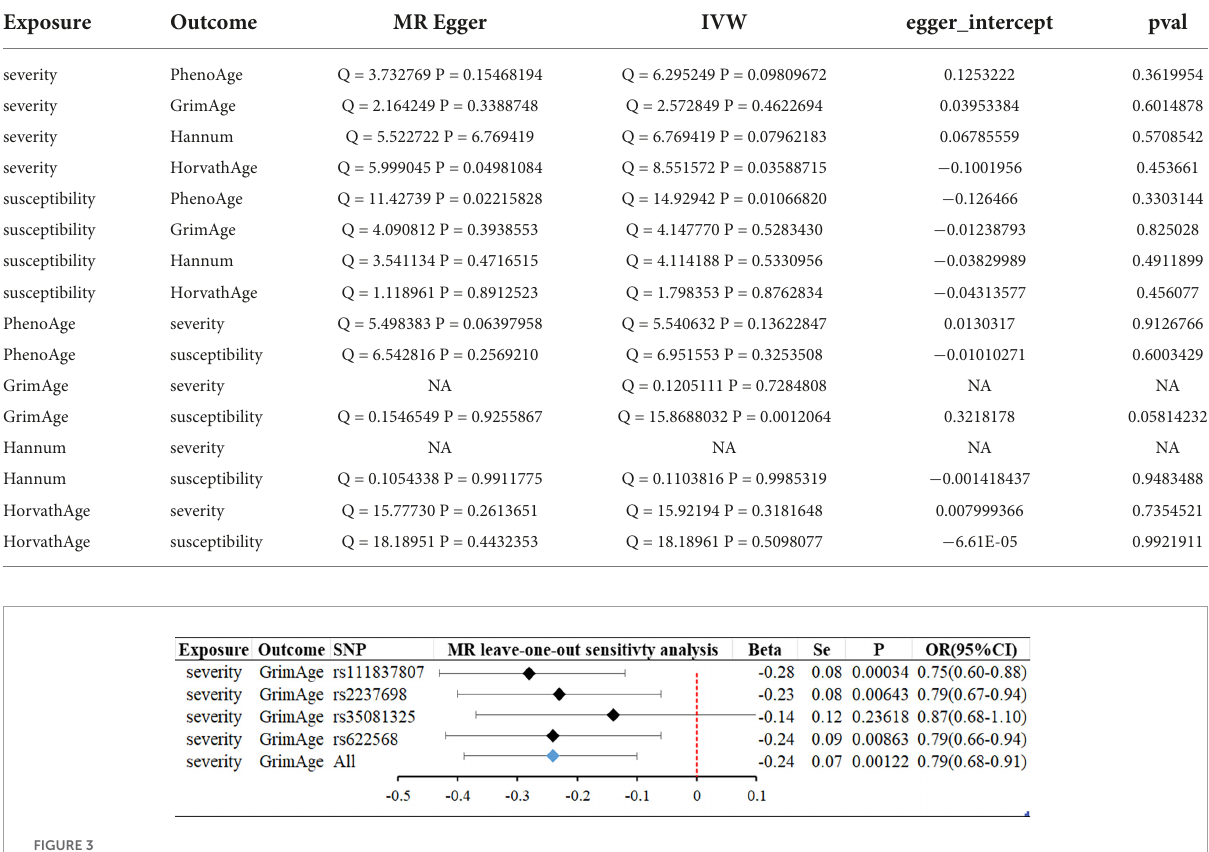
TABLE 2 Heterogeneity and pleiotropic analysis for epigenetic age and susceptibility and severity of COVID-19.